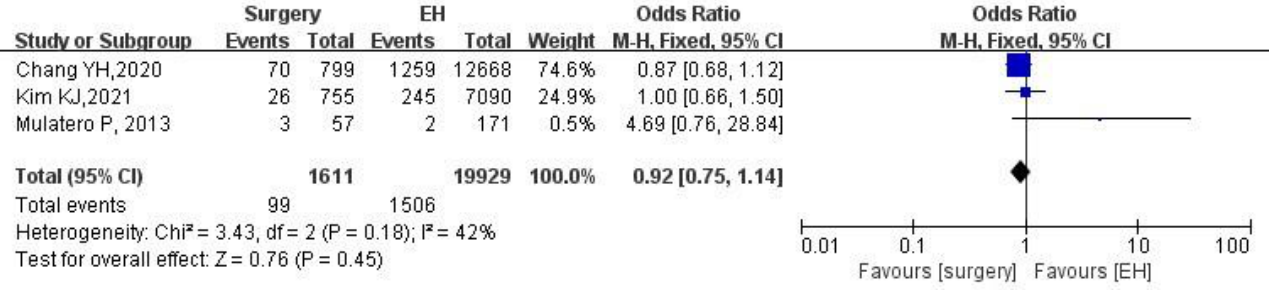
Figure 4. Forest plot of stroke in PA patients receiving surgical adrenalectomy treatment vs. EH patients. EH, essential hypertension; PA, primary aldosteronism. The blue squares represent the results of individual studies and the black diamonds represent the combined results of total studies in the model.